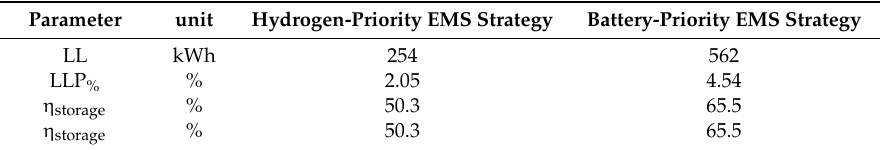
Figure 20. Net power balance. ( a ) Hydrogen-priority EMS strategy results; ( b ) battery-priority EMS strategy results. Table 5. Comparison of simulation results 1. Global parameters.